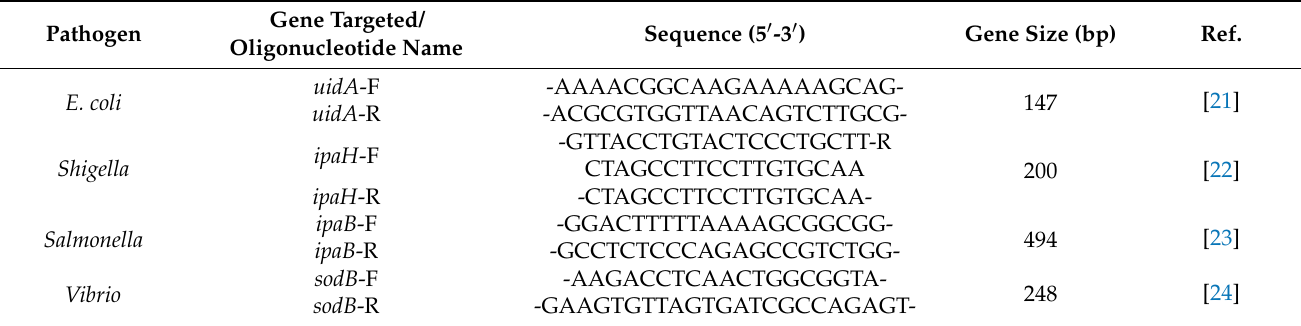
Table 1. Oligonucleotides used in this study for amplification of housekeeping genes for E. coli, Shigella, Salmonella, and Vibrio spp.